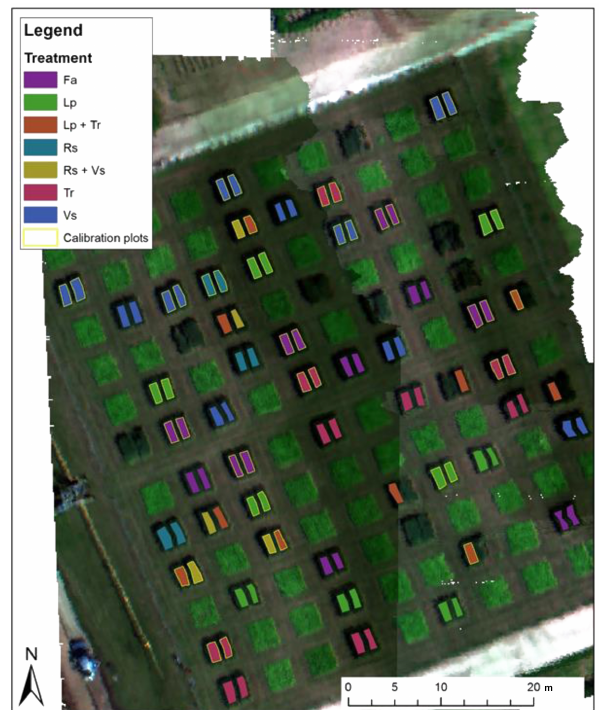
Figure 1. The experimental field as imaged from the Hyper- spectral Data Cube (HDC) acquired on 1 July 2015 represented as true colour RGB image, regions of interest (ROIs) for A. sativa (oat) plots and plot wise treatments. Plant legacy treatments are: Fa = fallow, Lp = Lolium perenne , Rs = Raphanus sativus , Tr = Trifolium repens , Vs = Vicia sativa , Lp + Tr = L. perenne + T. repens , Rs + Vs = R. sativus + V. sativa